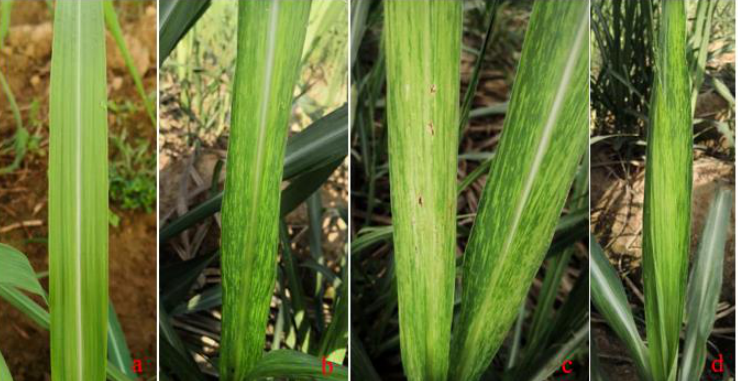
Figure 1. Symptoms of mosaic infection in sugarcane leaves. ( a ). healthy leaves; ( b ). infected leaves; ( c ). severely infected leaves; ( d ). abnormally twisted top leaves of infected plant.